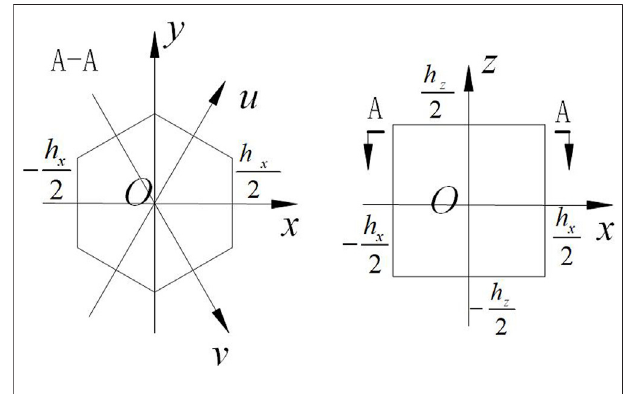
FIGURE 1 | Illustration of a hexagonal-Z